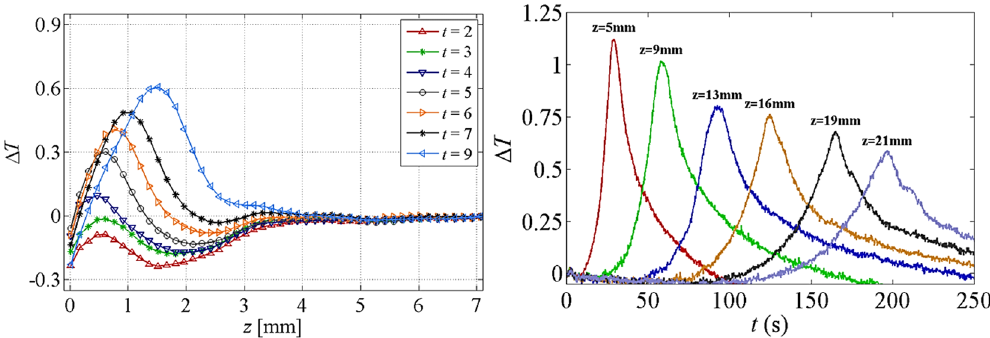
Figure 22. Averaged temperature distribution at various time frames at very initial imbibition stages